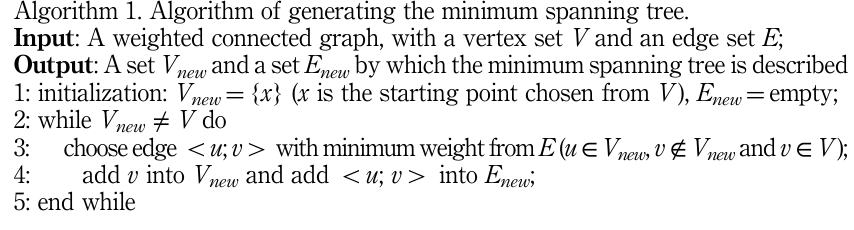
Algorithm 1. Algorithm of generating the minimum spanning